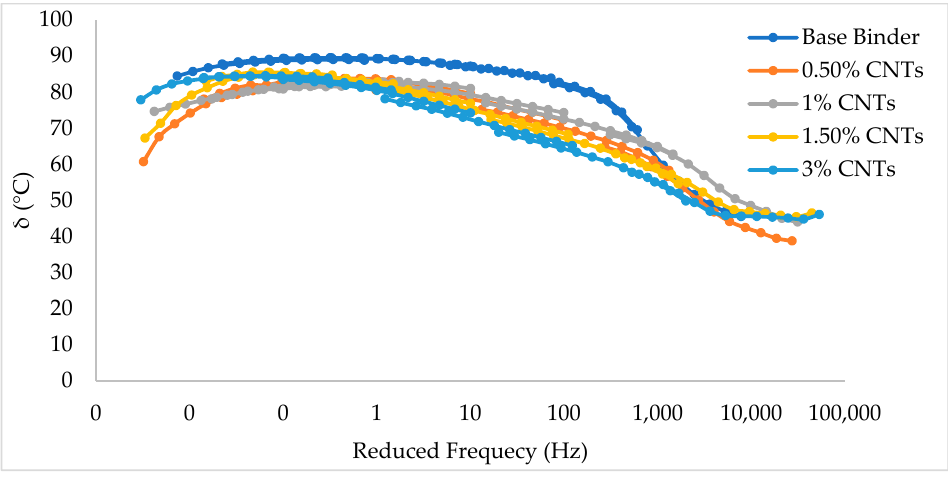
Figure 13. Master curve of δ for CNT-modified and unmodified bitumen at 58 °C.